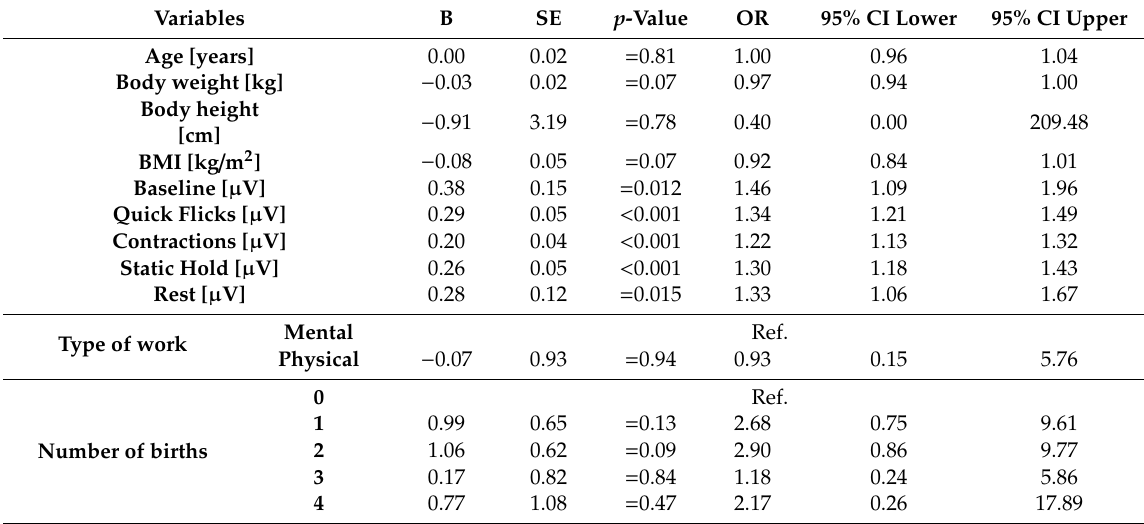
Table 3. Assessment of the impact of variables on the absence of stress urinary incontinence (univariate logistic regression